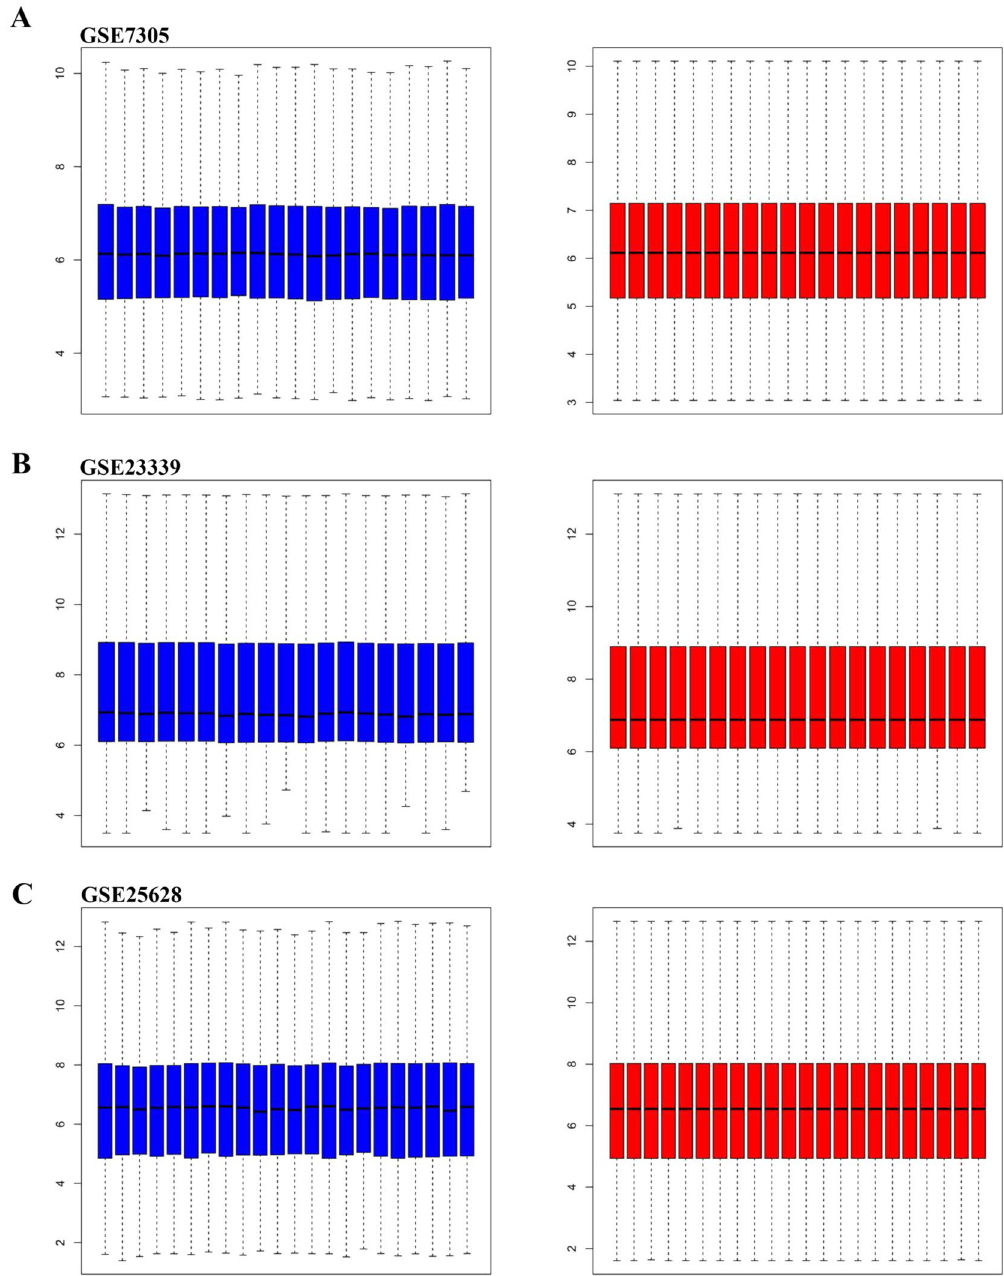
Figure 1. Box plot graph of value distribution of GSE7305 ( A ), GSE2339 ( B ) and GSE25628 ( C ) The left side is before normalization, the right side is after